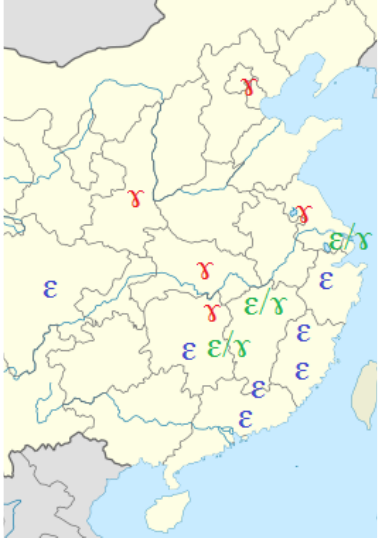
Figure 2. Open syllable unrounded mid-vowel contrasts. Table 1. Vowel inventories in open monophthongal syllables in Xiang varieties (north‑to‑south) 9 . Dialect Dialect Area High Front Mid-Front